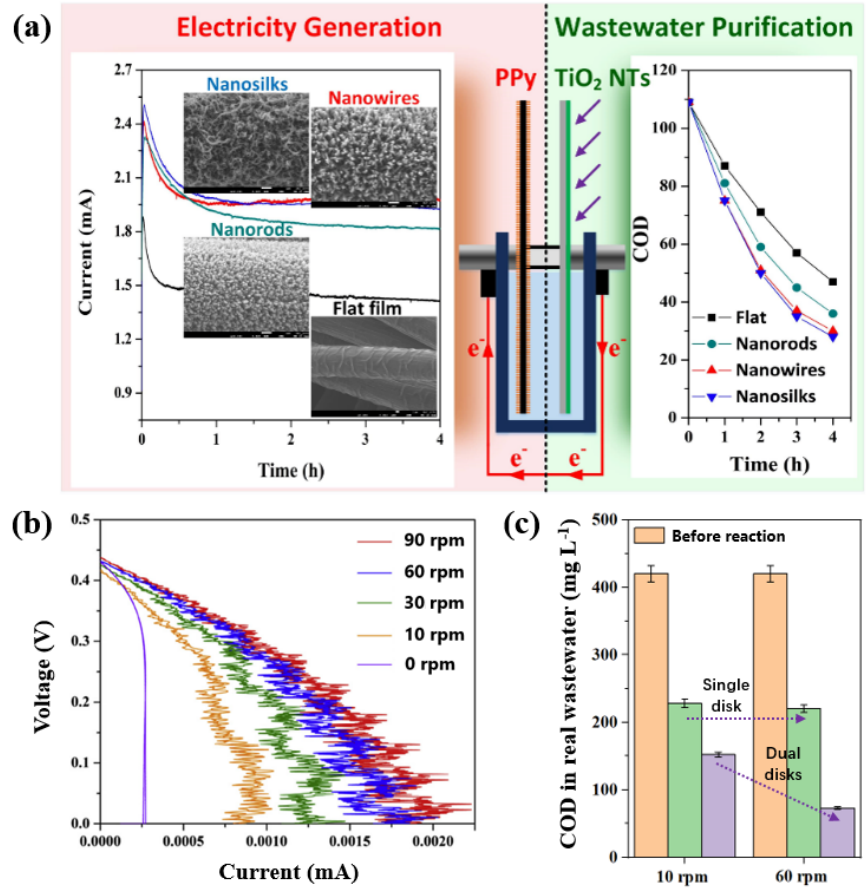
Figure 9. ( a ) Schematic diagram of dual rotating disk PFC with TiO 2 nanotube arrays as photoanode, nanostructured PPy as cathode, and the corresponding short circuit current-time curves and COD removals in real wastewater (Reprinted/adapted with permission from Ref. [93]. 2019, ELSEVIER.), ( b ) voltage–current curves obtained at different rotating speed in a dual rotating disk PFC (Reprinted/adapted with permission from Ref. [92]. 2016, ELSEVIER.), and ( c ) effects of rotating speed on COD removal in a single rotating disk PFC and dual rotating disk PFC.